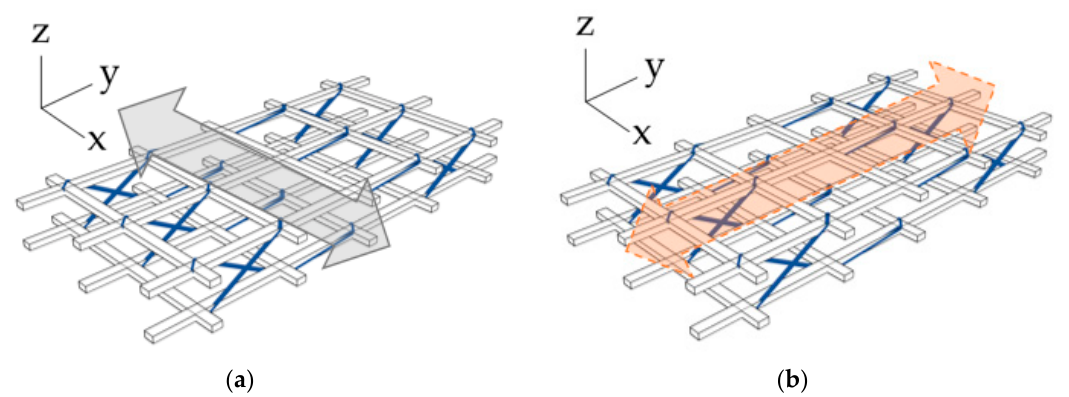
Figure 9. Schematic representation of loading in ( a ) x-direction, ( b ) y-direction for the woven 3D TRC system.